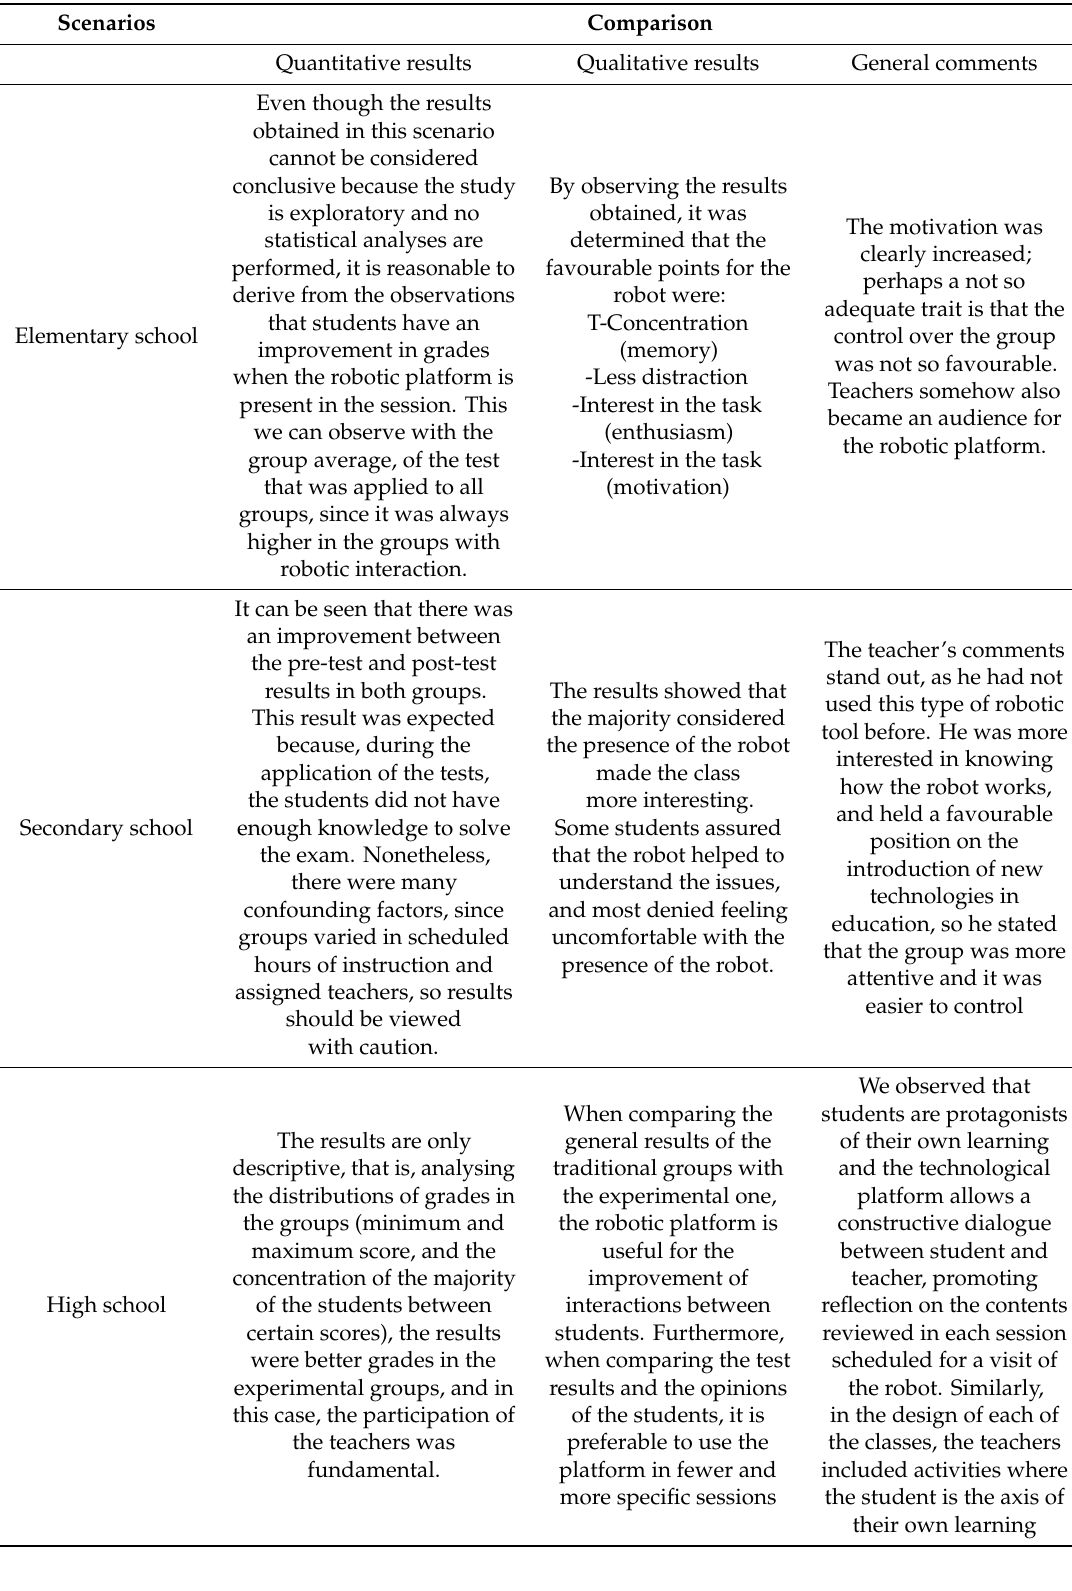
Table 4. Summary of observations and test